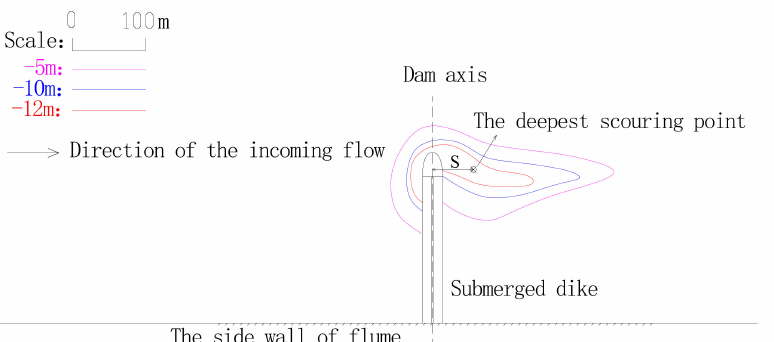
Figure 7. Picture of distance from the deepest scouring point near the dam head to the dam